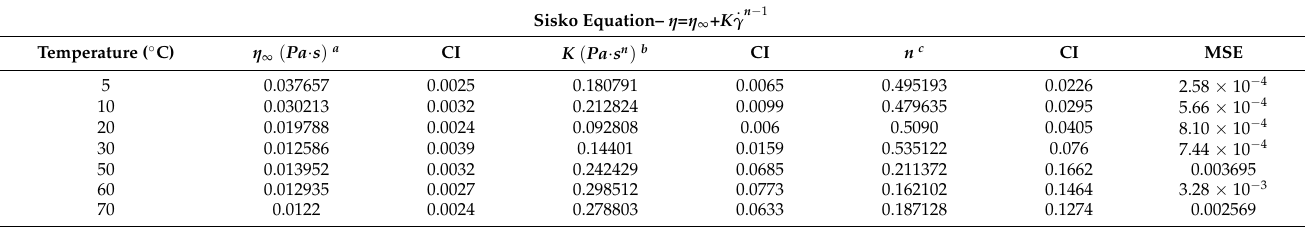
Table A4. Fitting parameters ( η ∞ , K , n ), confidence intervals (CI), and mean square error (MSE) values as a function of temperature obtained from the modified Ostwald–de Waele model by Sisko, or Sisko equation [47], modeling the 0.1 to 1000 s − 1 shear rate range for flow curve data sets of ink suspensions with a 0.40 wt% HRCM load.